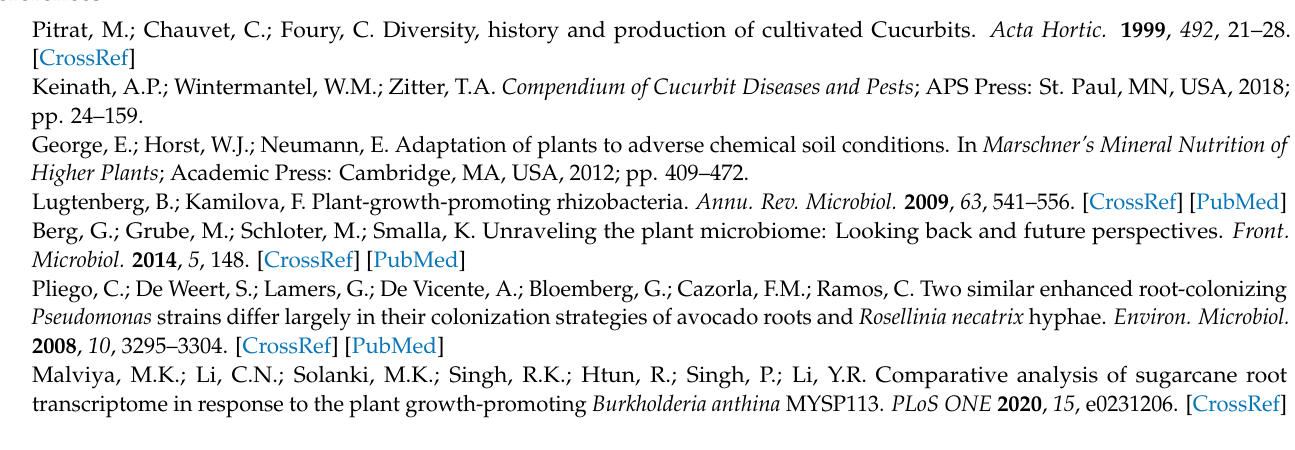
Table S2: Gene Ontology (GO) enrichment results of up-regulated differentially expressed genes (DEGs) in Bacillus subtilis MBI600 ( Bs MBI600)-treated cucumber roots. DEGs are categorized accord- ing to biological process and molecular function., Table S3: Gene Ontology (GO) enrichment results of down-regulated differentially expressed genes (DEGs) in Bacillus subtilis MBI600 ( Bs MBI600)-treated cucumber roots. DEGs are categorized according to biological process and molecular function., Table S4: Metabolite amounts (means ± SE) expressed as relative abundance based on the relative response compared to internal standard adonitol, 24 h post-application of Bacillus subtilis MBI600 ( Bs MBI600)., Table S5: Metabolite amounts (means ± SE) expressed as relative abundance based on the relative response compared to internal standard adonitol 48 h post-application of Bacillus subtilis MBI600 ( Bs